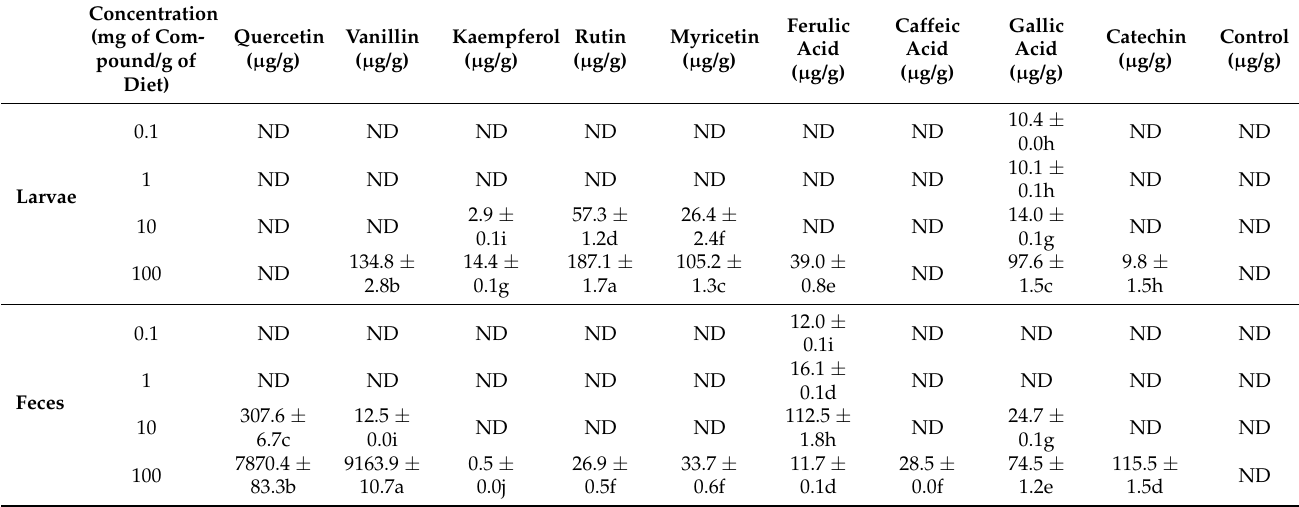
Table 6. Concentration of compounds in bodies and feces of C. rudis. Letters indicate significant differences according to ANOVA and Tukey’s test separately for larvae and feces ( p ≤